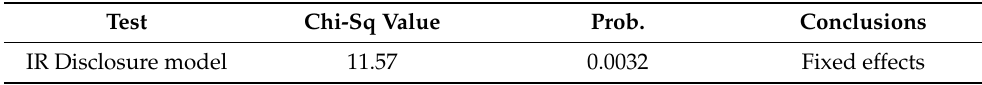
Table 2. Hausman test